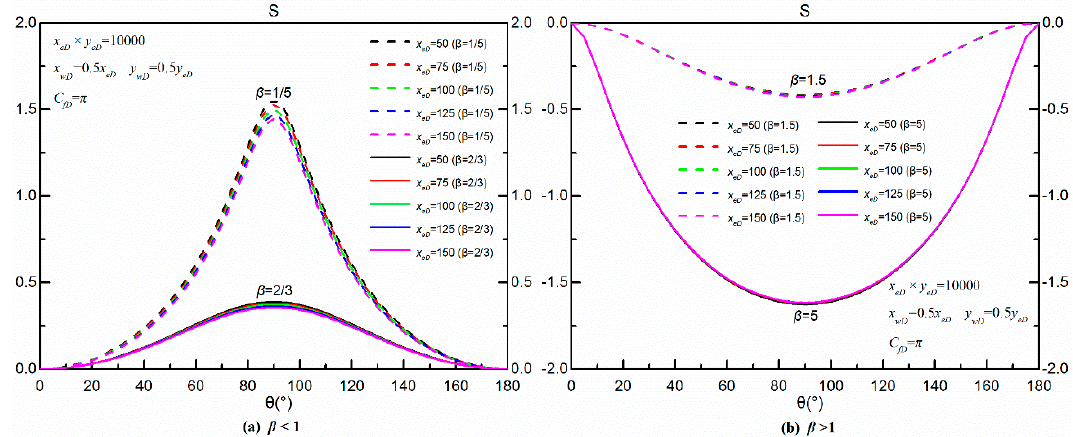
β ≥ . Figure 10. E ff ect of reservoir shape on pseudo-skin factor: ( a ) β < 1; ( b ) β ≥